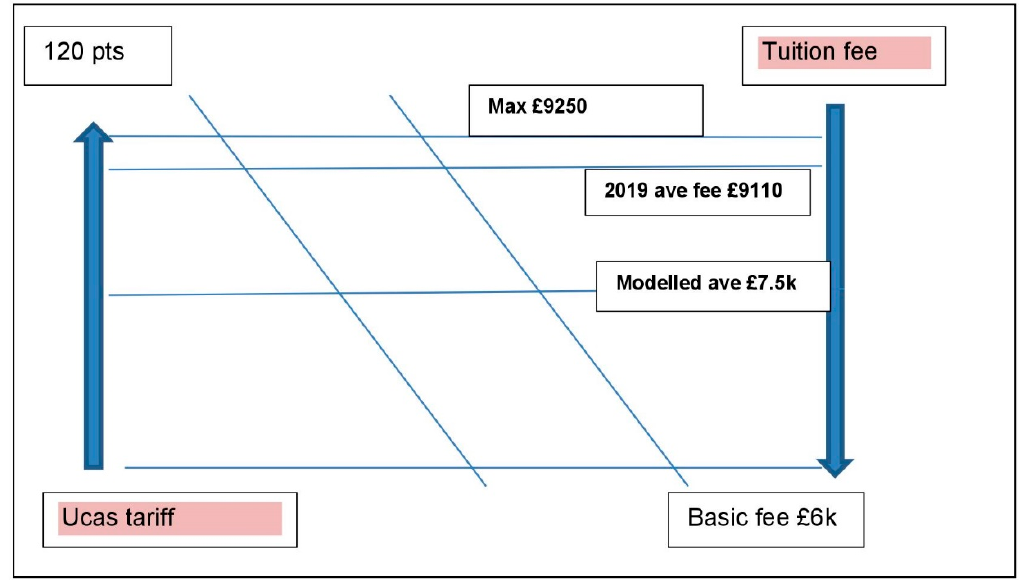
Figure 1. Dual Price Scale.